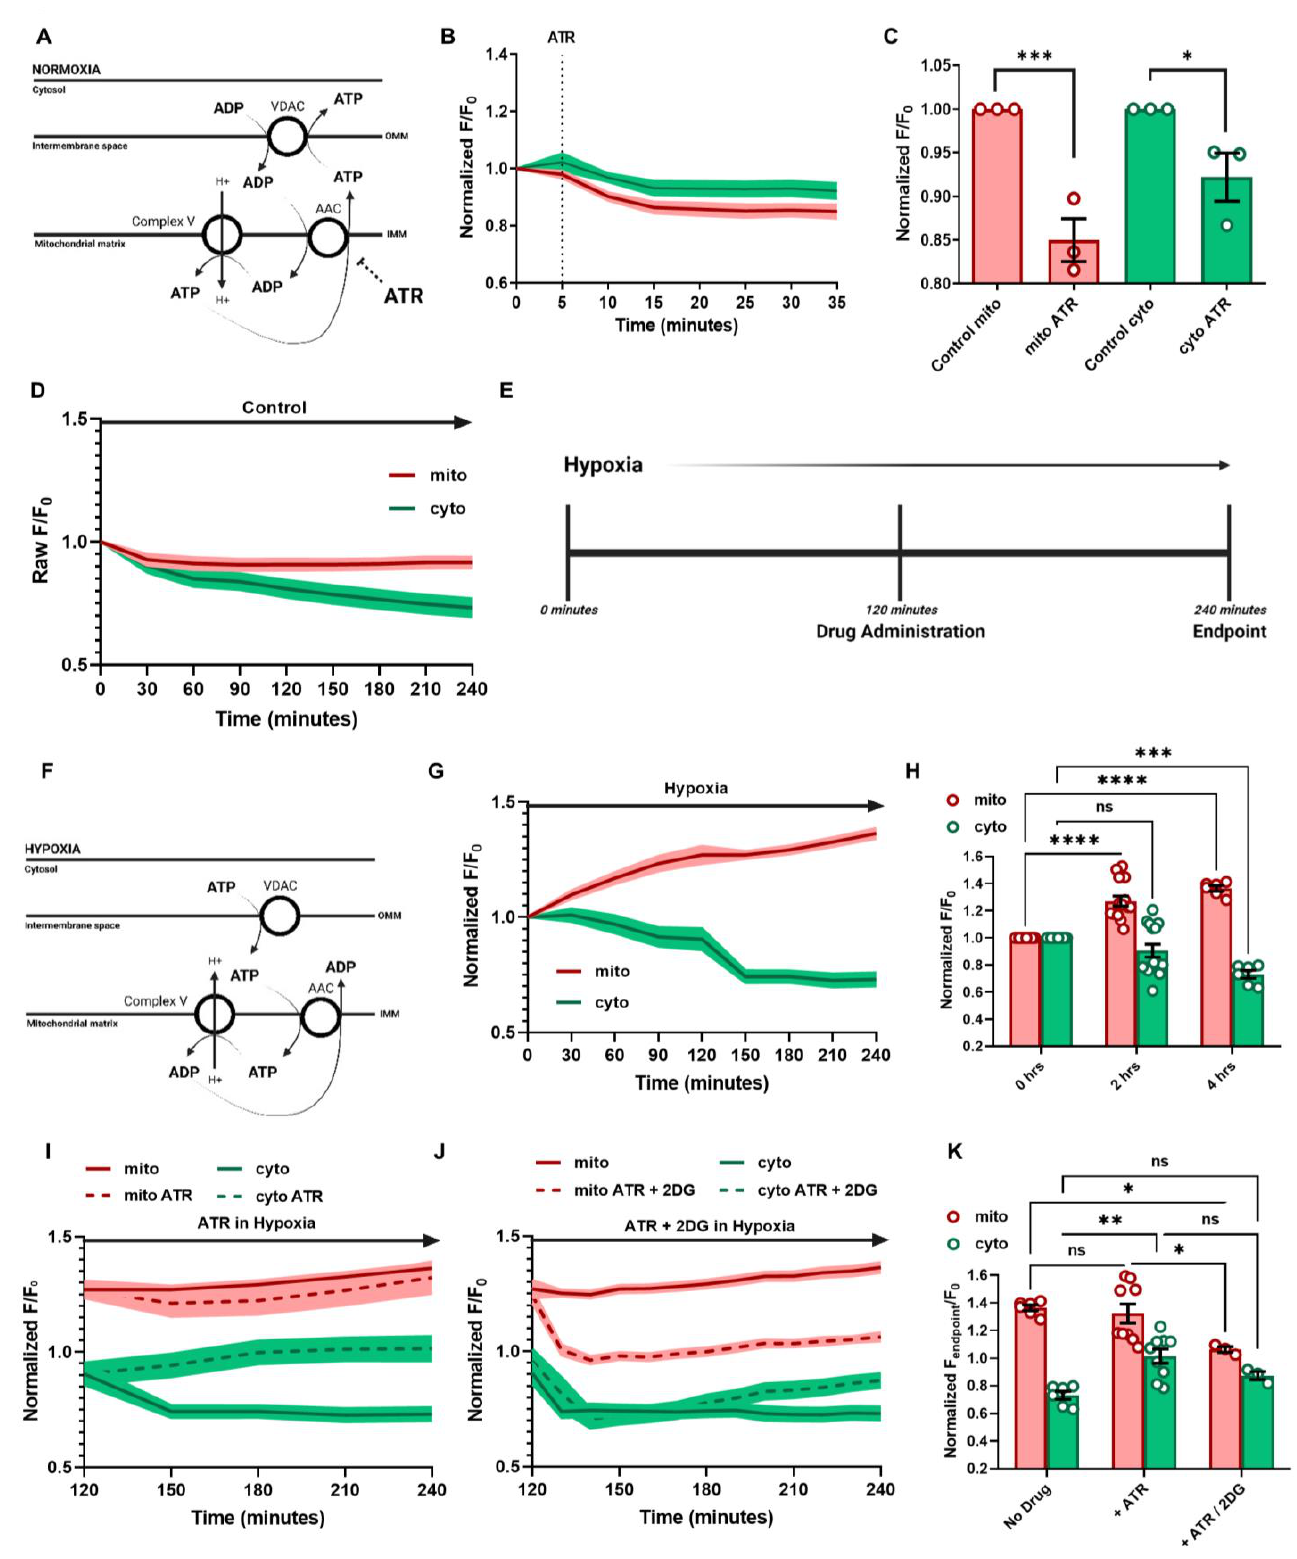
Figure 4. Effects of ADP/ATP Carrier (AAC) inhibition on spatiotemporal ATP dynamics in cultured HEK293T cells under normoxic and hypoxic conditions. ( A ) Under normoxic conditions, AAC facilitates the movement of ATP out of the matrix, while also bringing ADP to feed the ATP synthesis. ( B , C ) smacATPi-transfected HEK293T cells were treated with atractyloside (ATR), an AAC inhibitor, under normoxia. ( D ) A 4-h normoxic control run was used to normalize the hypoxia cell runs. ( E )